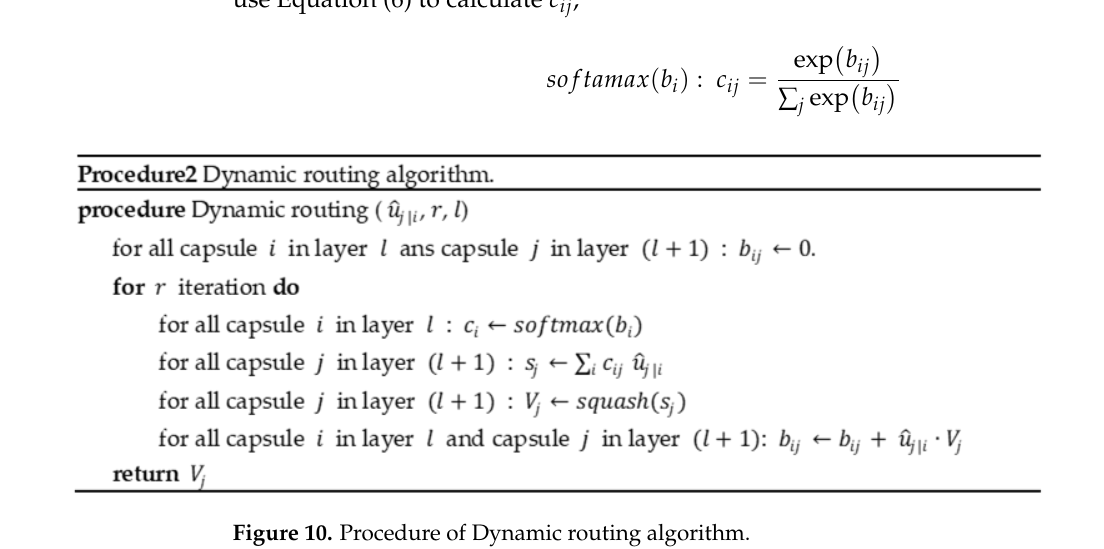
Figure 10. Procedure of Dynamic routing algorithm.